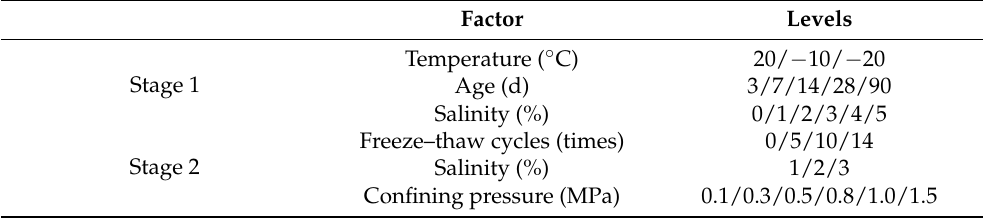
Table 3. Factors and